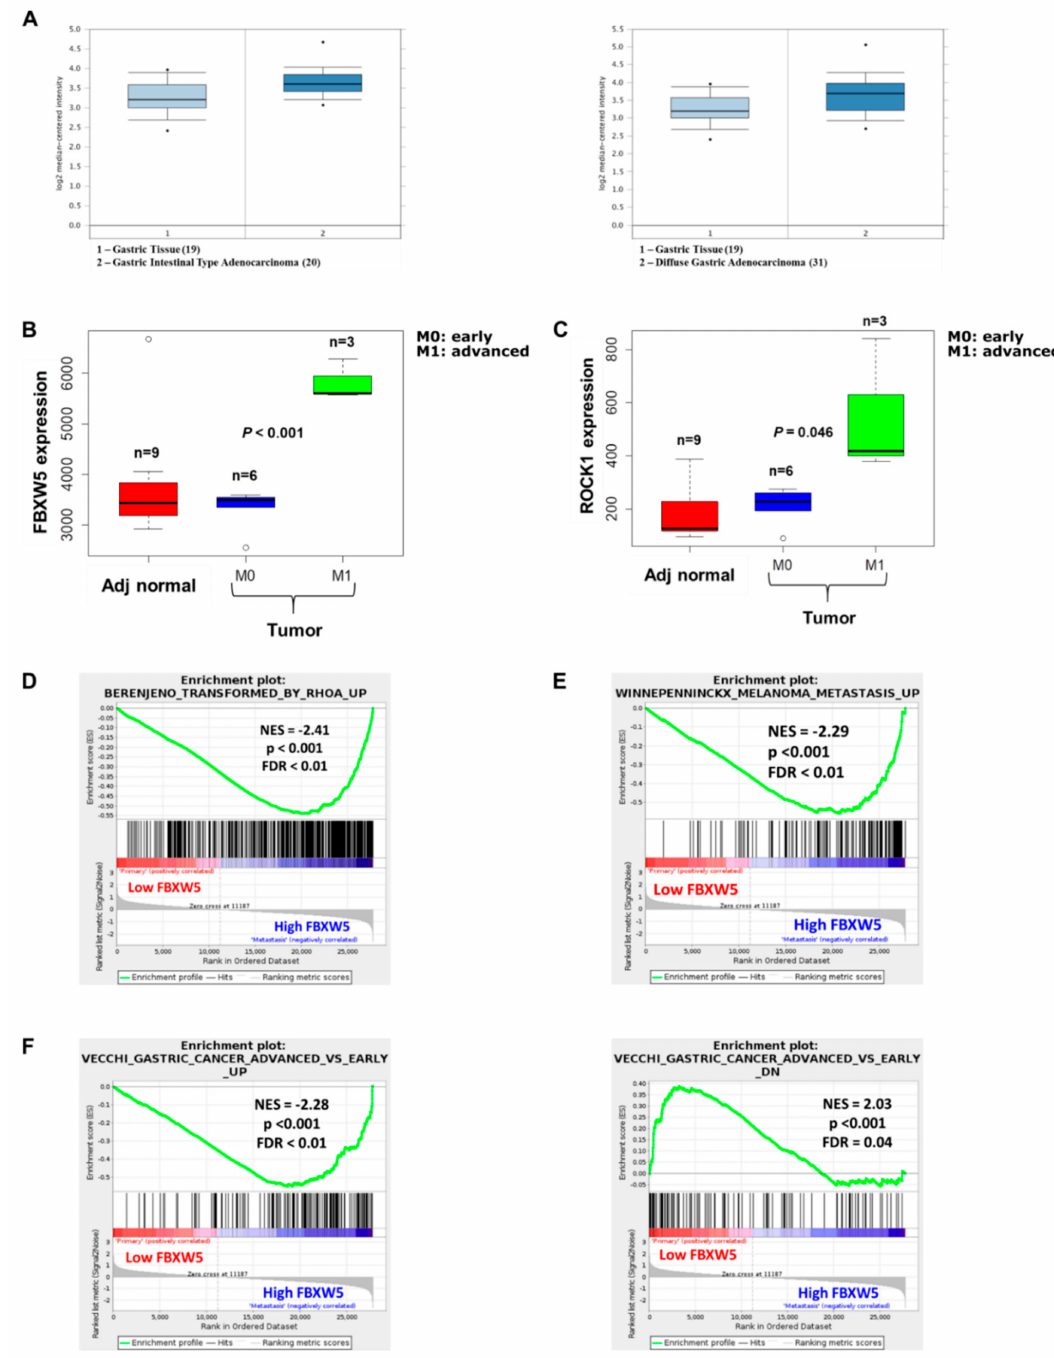
Figure 6. ( A ) FBXW5 expression level across healthy gastric tissues, intestinal-type (left panel) and di ff use-type (right panel) tumor tissue samples (gastric cancer: GSE13861). ( B ) FBXW5 expression across adjacent healthy, early, and advanced tumor tissues (gastric cancer: GSE103236). ( C ) ROCK1 expression across adjacent healthy, early, and advanced tumor tissues (gastric cancer: GSE103236). ( D ) GSEA plot showing enriched RhoA signaling in high FBXW5 tumors compared to low FBXW5 tumors. ( E ) GSEA plot showing enriched metastasis in high FBXW5 tumors compared to low FBXW5 tumors. ( F ) GSEA plot showing enriched advanced tumors in high FBXW5 tumors (left panel) and enriched early tumor in low FBXW5 tumors (right